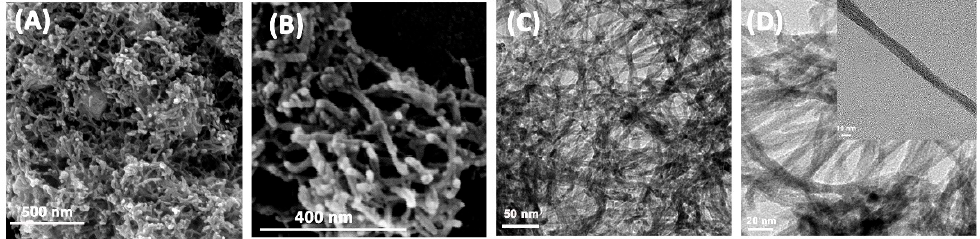
Figure 2. Scanning electron microscopy (SEM) ( A , B ) and transmission electron microscopy (TEM) ( C , D ) images of the prepared Cu 2 O one-dimensional nanowires.